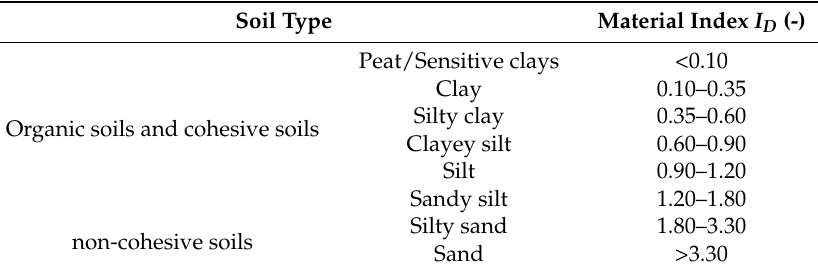
Table 1. Soil classification based on material index I D